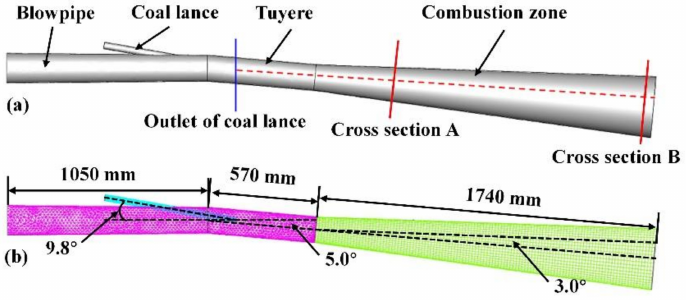
Figure 1. Geometric model ( a ) and mesh ( b ) of the blowpipe-tuyere-combustion zone in the